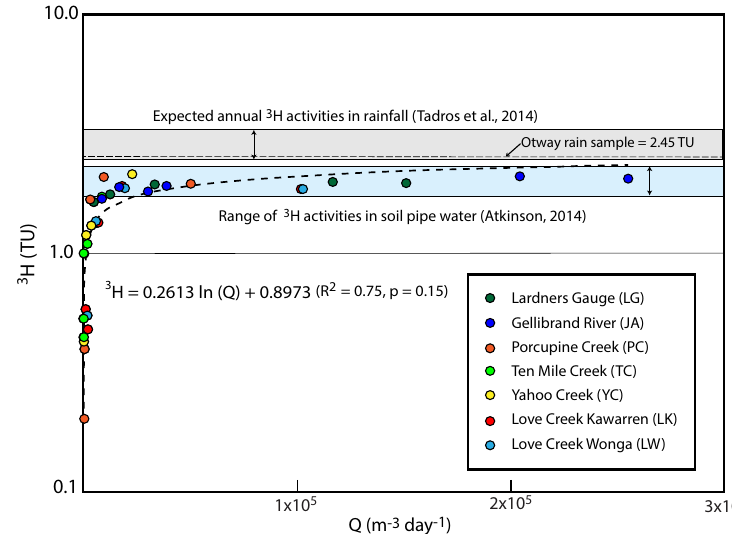
Figure 4. 3 H activities of stream water as a function of streamflow for all catchments except Upper Lardners which is ungauged. 3 H data from Supplement, streamflow data from Department of Environment, Land, Water and Planning (2017) or calculated as discussed in the text. Shaded boxes show the expected annual average of rainfall 3 H activities from Tadros et al. (2014) and soil waters from Atkinson (2014).